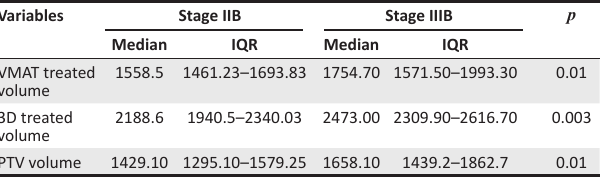
TABLE 3: Volume comparisons between three-dimensional conformal radiation and volumetric modulated arc therapy for Stages IIB and IIIB.